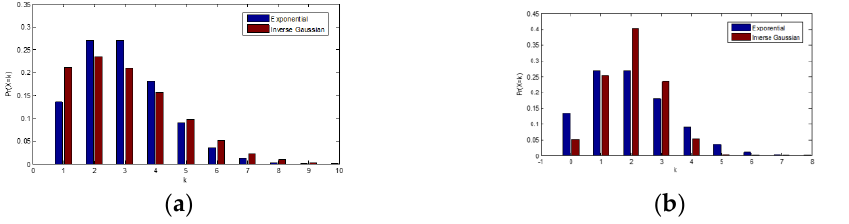
Figure 1. Plots of Poisson and inverse Gaussian probabilities: ( a ) λ = 0.17, μ = 1 (over dispersion); ( b ) λ = 1, μ = 0.438 (under dispersion).